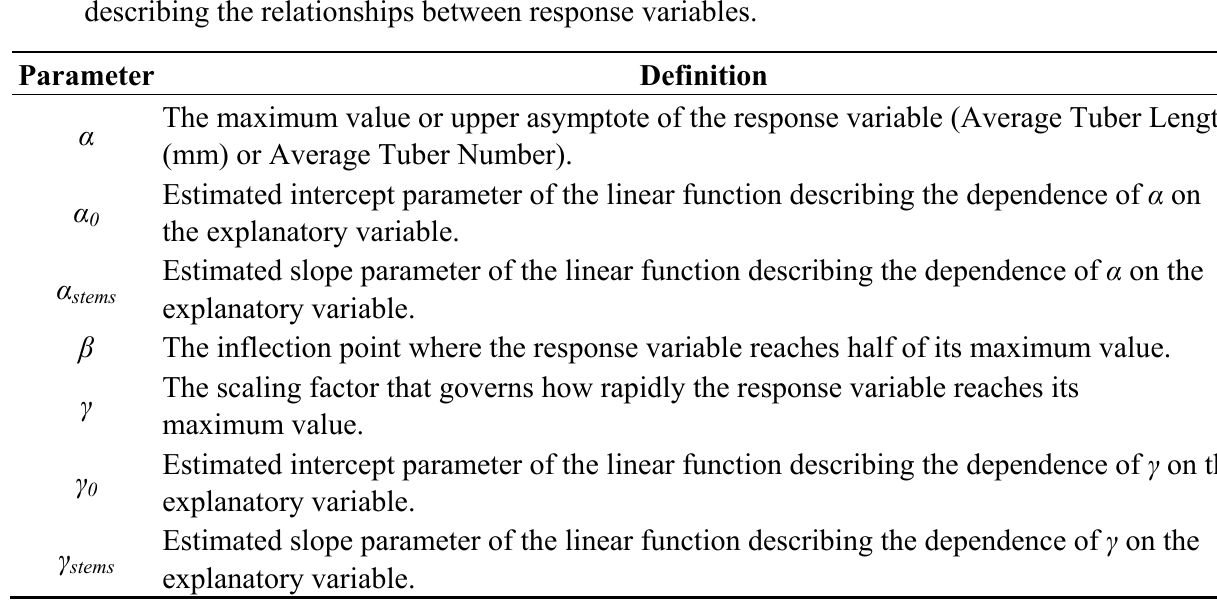
Table 1. Response variables, explanatory variables and estimated parameters utilized in describing the relationships between response